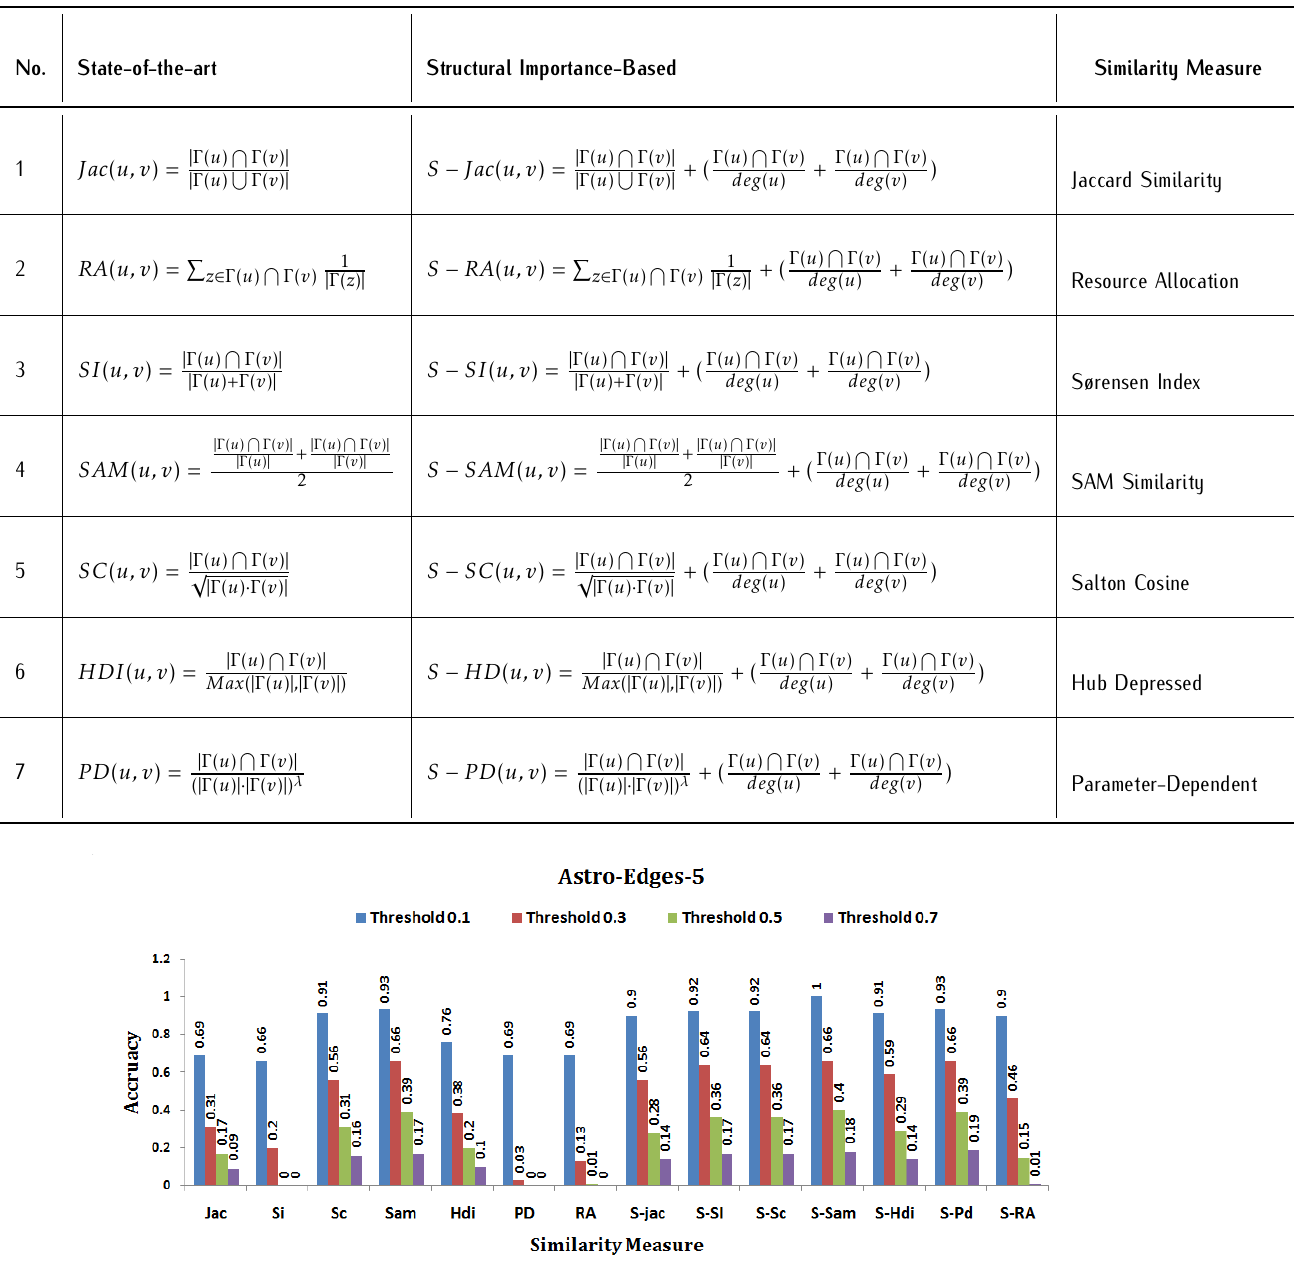
Table 3. Structural Importance based State-of-the-art Similarity Measures